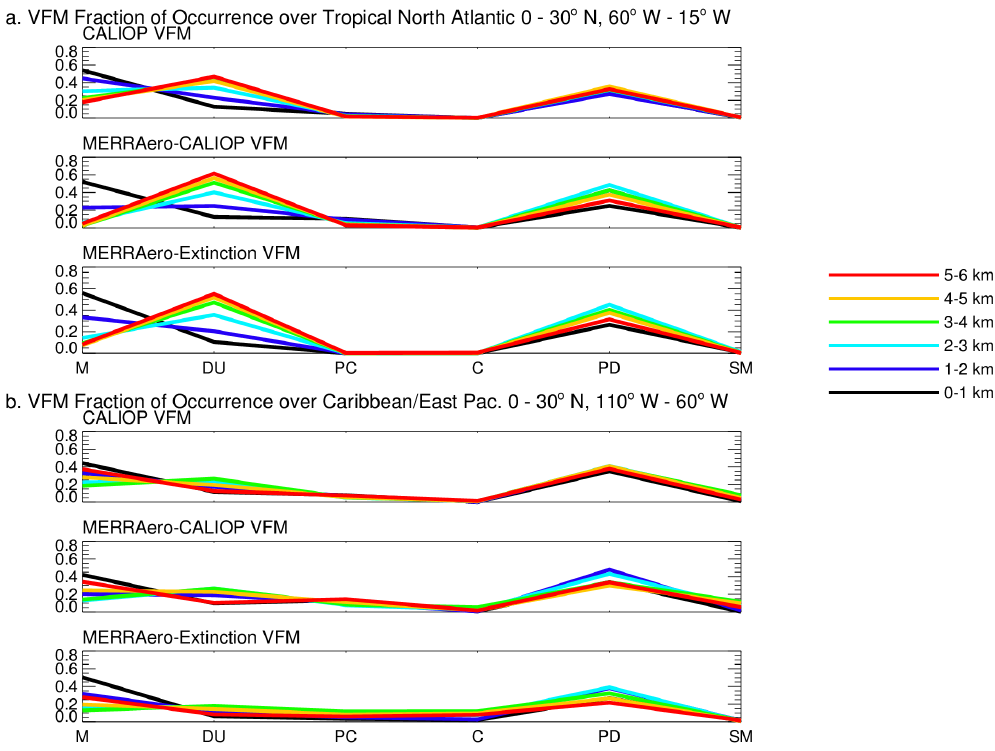
Figure 8. VFM fraction of occurrence over the tropical North Atlantic (a) and Caribbean/eastern Pacific (b) . Aerosol types include marine (M), desert dust (DU), polluted continental (PC), clean continental (C), polluted dust (PD), and smoke